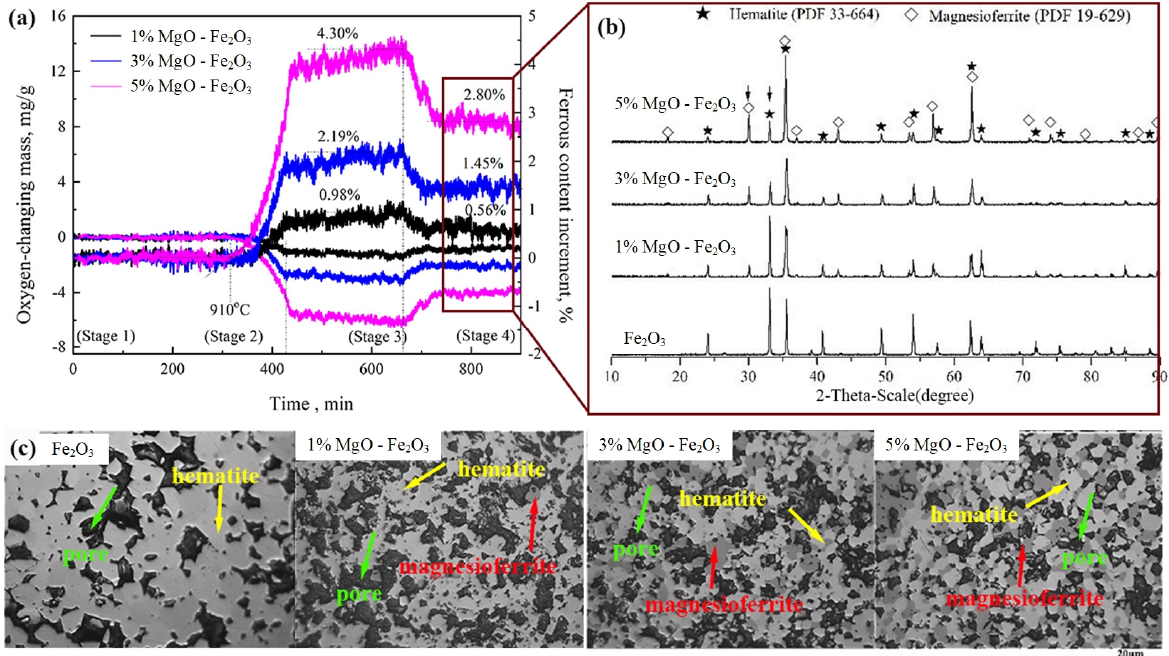
Figure 4. Effects of MgO content on transformation of hematite to magnesioferrite in the preheated samples. ( a ) Variations in ferrous content from Stage 1 to Stage 4; ( b ) XRD patterns at Stage 4; ( c ) micrographs at Stage 4.